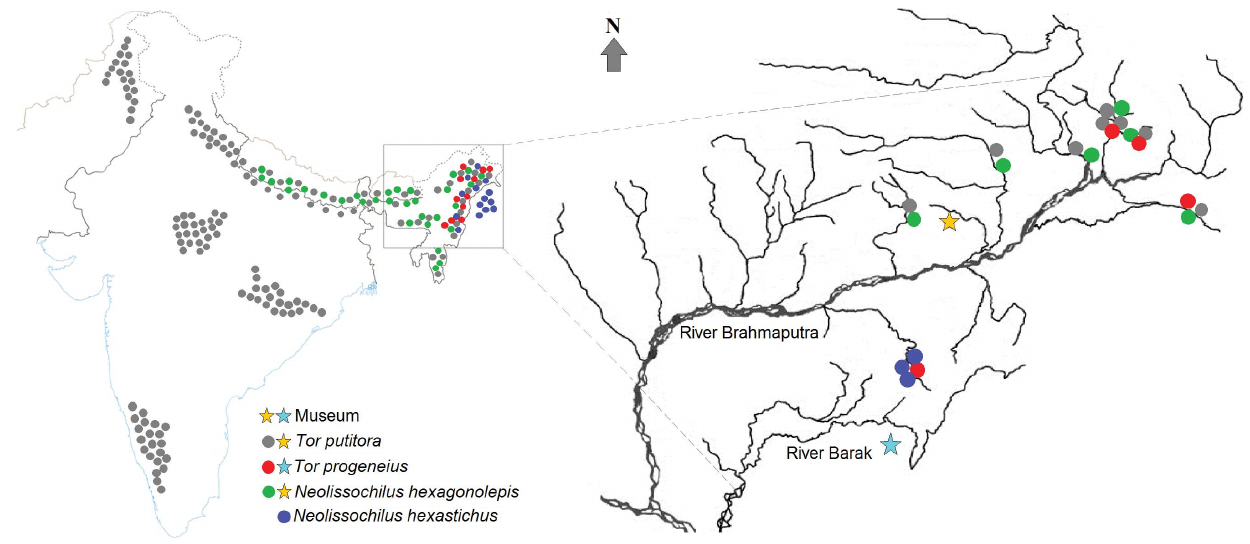
Figure 1. Map of the study site showing the known distribution of the studied species and the collection sites in different river drainages. The figure shows that the Northeastern region of India is drained mostly by River Brahmaputra and partly by River Barak. The studied specimens were collected from the drainages of River Brahmaputra. The topography of the region restricts the convergence of Southeast Asian fish composition with this